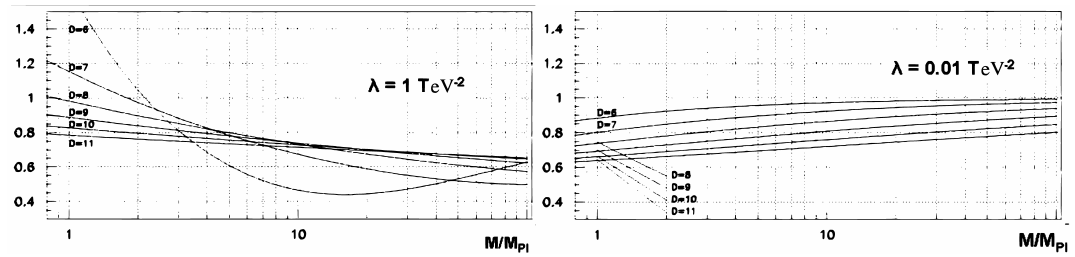
Figure 4. Ratio of the temperatures with and without the Gauss–Bonnet term as a function of mass. Reproduced from